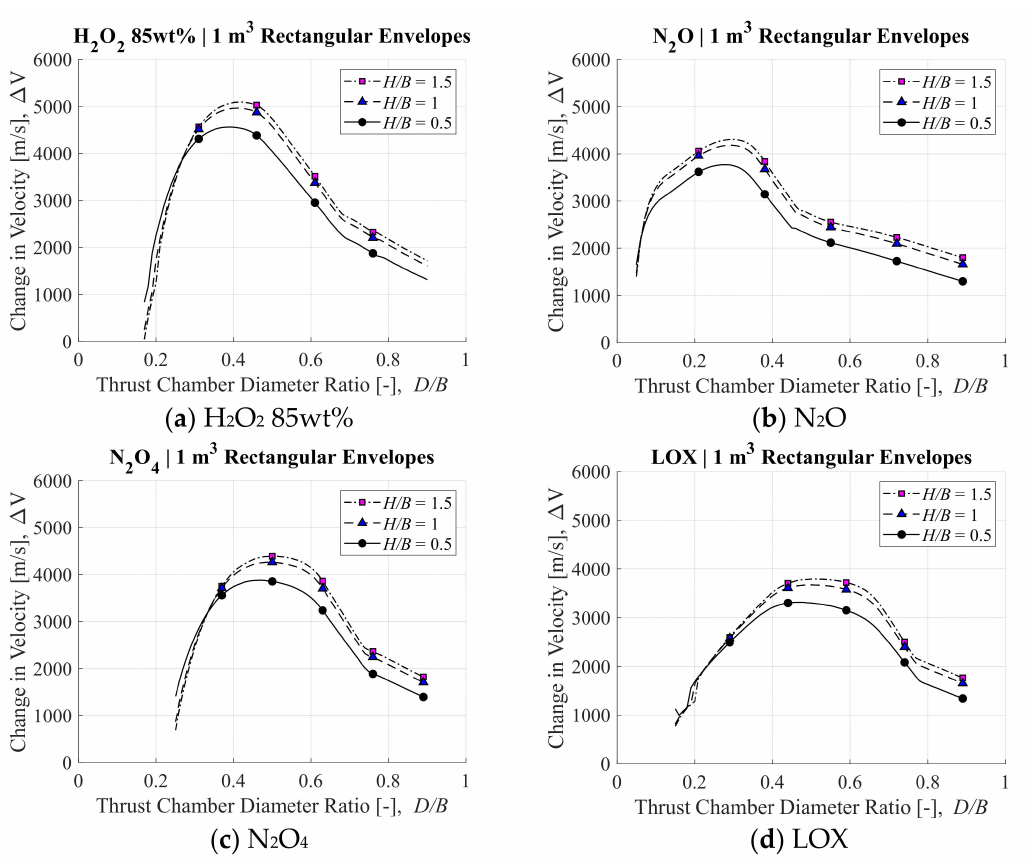
Figure 10. Ideal performance of hybrid rocket-based post-boost stages or kick motors using: ( a ) H2O2 85wt%, ( b ) N 2 O, ( c ) N 2 O 4 , or ( d ) LOX as